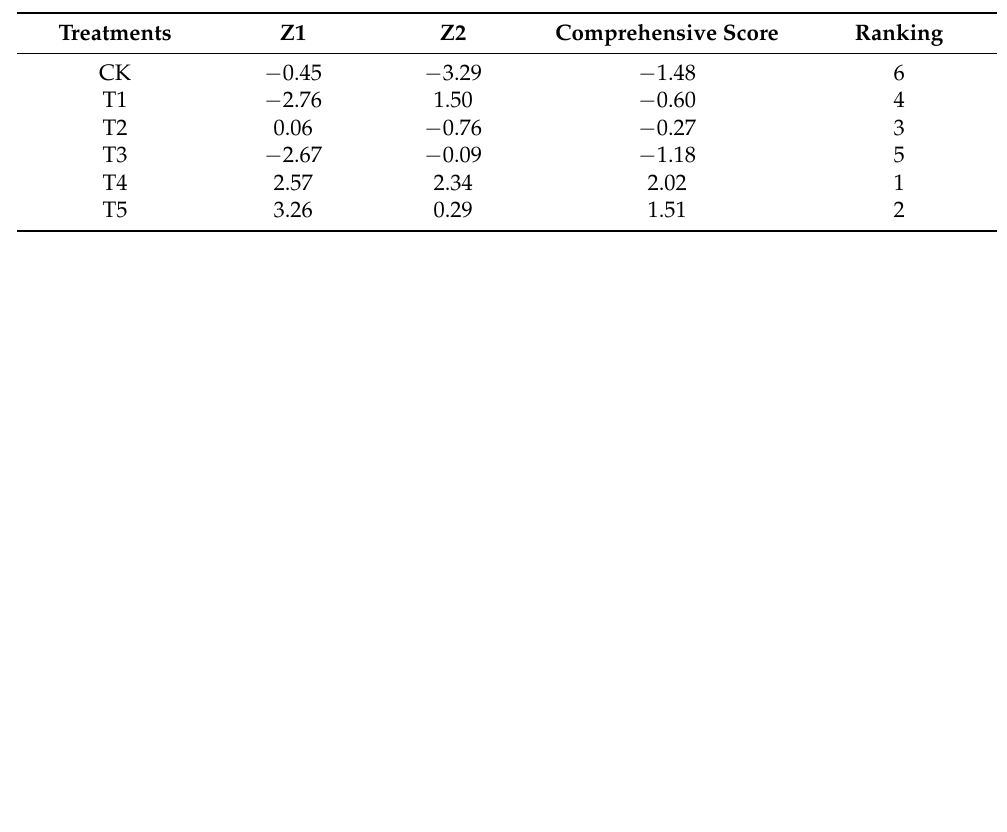
Table 5. ScoresofNH 4+ :NO 3 −